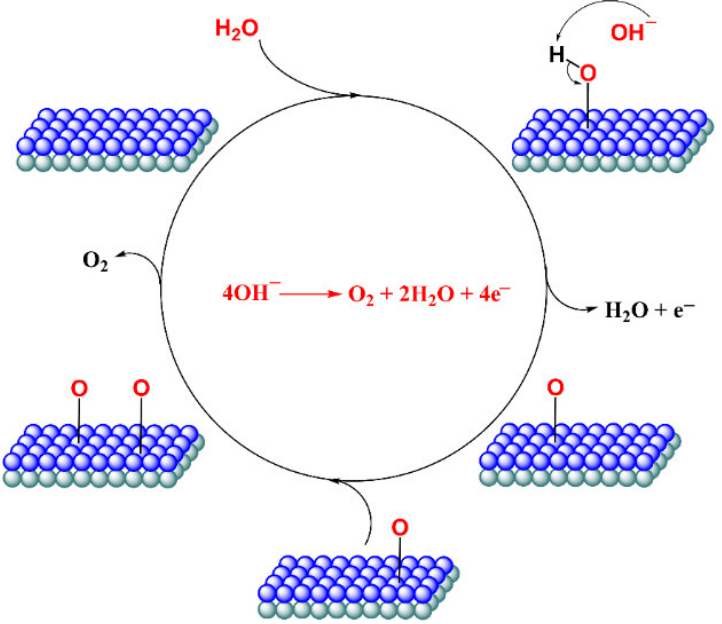
Figure 2. Mechanism of heterogeneous water oxidation in basic condition. Motivated from ref. [71] and Wikipedia (https://en.wikipedia.org/wiki/Heterogeneous_water_oxidation#cite_note-Birss1-5 (accessed on 10 October 2022)).